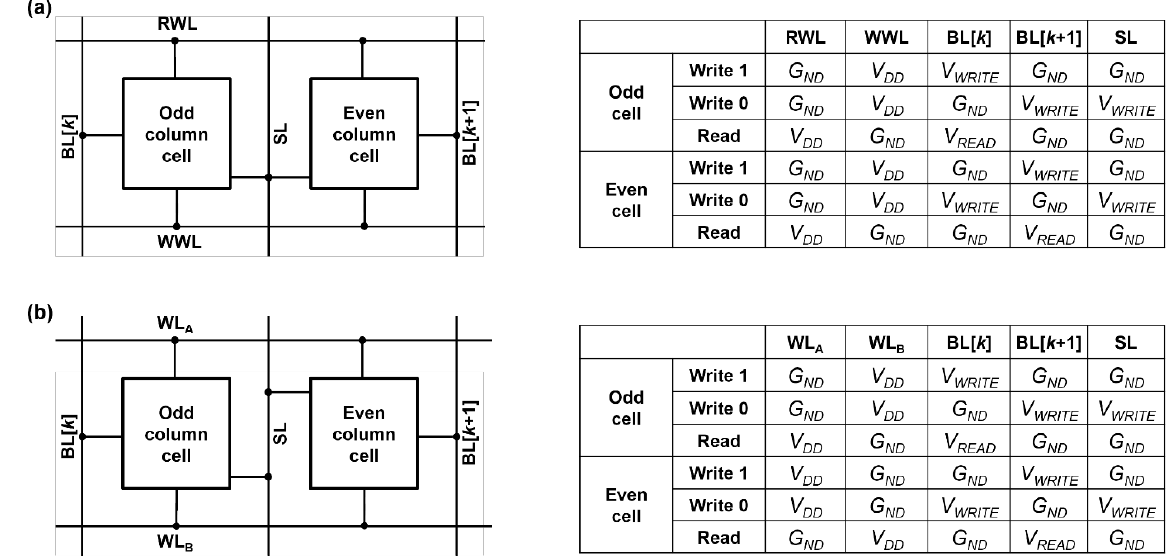
Figure 7. Biasing conditions of ( a ) F-SOT-MRAM and ( b ) R-SOT-MRAM.